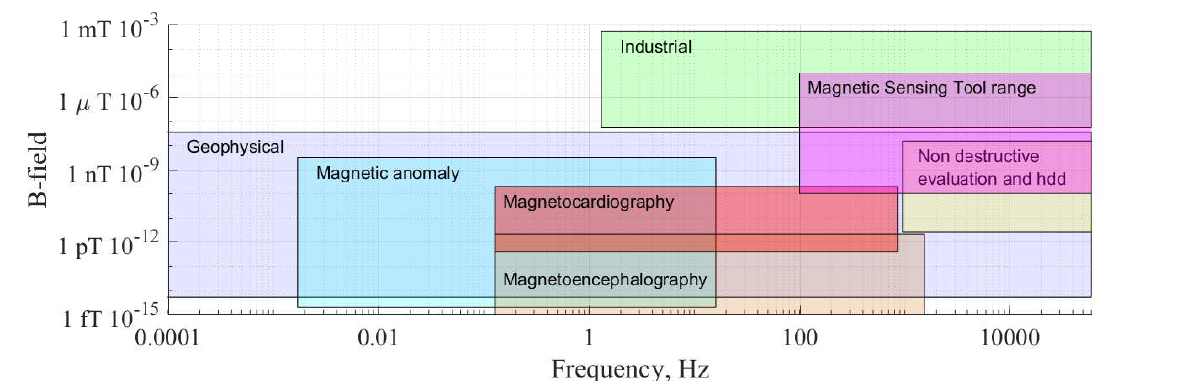
Figure 1. Magnetic field ranges and frequencies used in different disciplines, compiled after Ripka [23]. The range of B-field magnitude and frequency used in the numerical experiments discussed in this paper is marked in